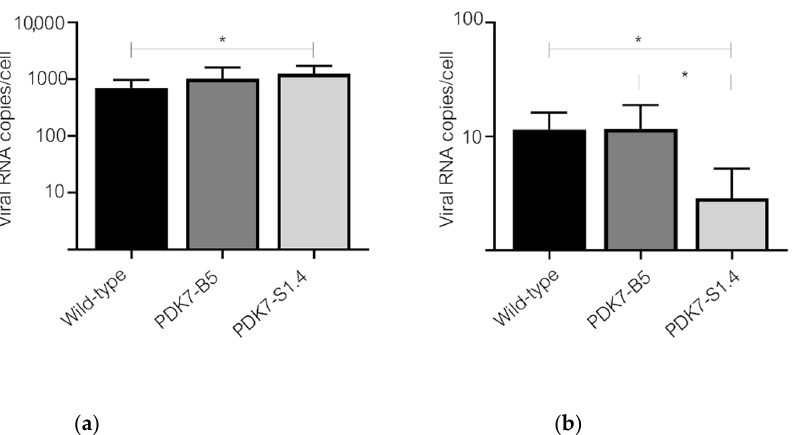
Figure 7. Viral entry into C6/36 ( a ) and Vero ( b ) cells was determined by real-time PCR. The viral RNA copies number per cell was determined by real-time PCR. The cells were infected with ZIKVs, wild-type, ZIKV-PDK7-B5, and ZIKV-PDK7-S1.4, at an MOI of 10. After viral adsorption, the viruses were removed and treated with acid glycine to inactivate the remaining un-internalized viruses. After 24 h post-infection, the infected cells were harvested for RNA extraction and subjected to one-step real-time PCR. The experiment was performed in triplicate with triplicate real-time PCR quantification. The bar graph represents mean values, with the error bar representing SD. One-way ANOVA was used, and asterisks (*) indicate a statistically significant difference ( p <